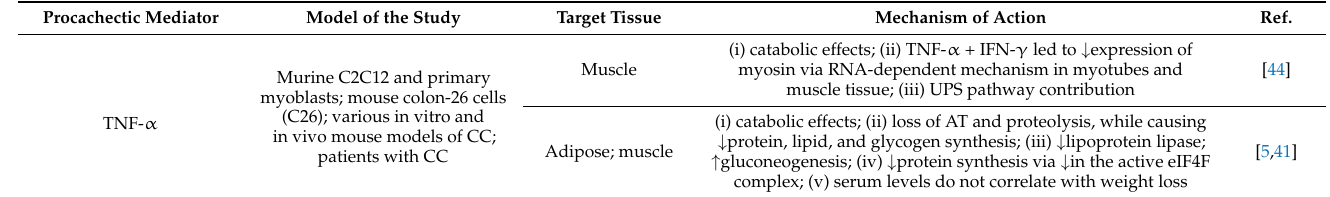
Table 1. Summary of some mechanisms and effects of selected procachectic mediators involved in the cancer cachexia. Procachectic